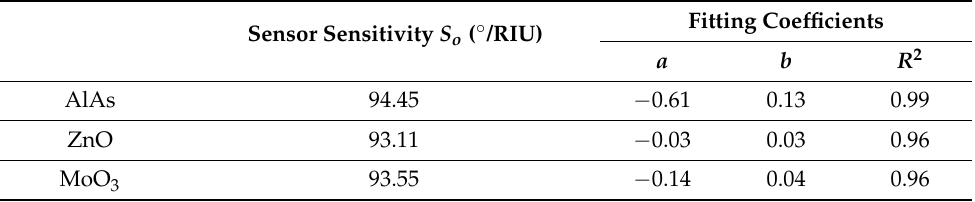
Table 4. Kinetic parameters for sensor sensitivity performance with three different materials of outermost layer (AlAs, ZnO, and MoO 3